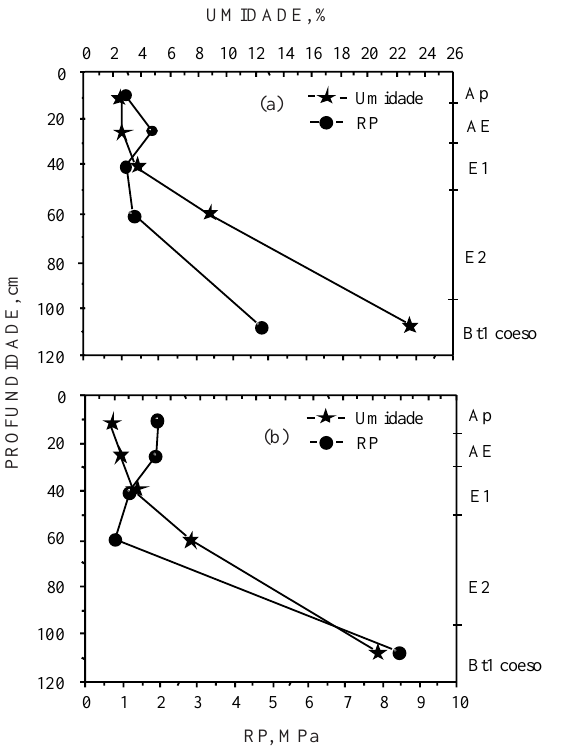
Figura 2. Curvas de resistência à penetração (RP) e de umidade do solo de um Argissolo Acinzentado coeso (P2). (a) leituras de RP e umidade realizadas em solo úmido (período da manhã) e (b) leituras de RP e umidade realizadas em solo mais endurecido decorrente do secamento (período da